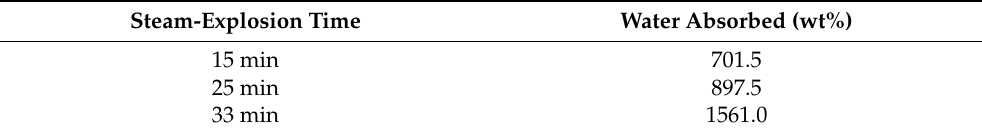
Figure 8. Static water contact angles tests for cellulose extracted at different steam-explosion times (15 min, 25 min and 33 min). ( a ) 15 min, ( b ) 25 min, ( c ) 33 min. Table 5. Static water absorption tests for cellulose fibers isolated at different steam-explosion times (15 min, 25 min and 33 min).